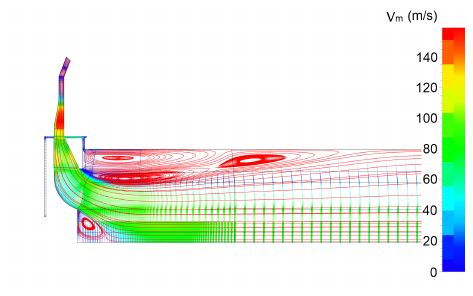
Figure 12. 28 000 rpm, SST k- ω .